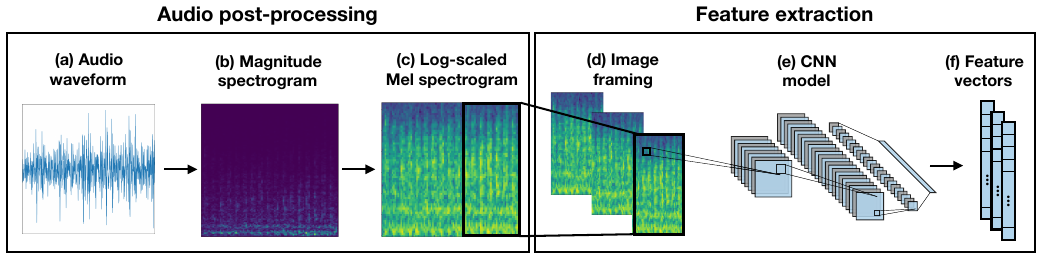
Figure 3. Audio post-processing and feature extraction applied to one of the audio waveforms from the ‘Small Aircraft’